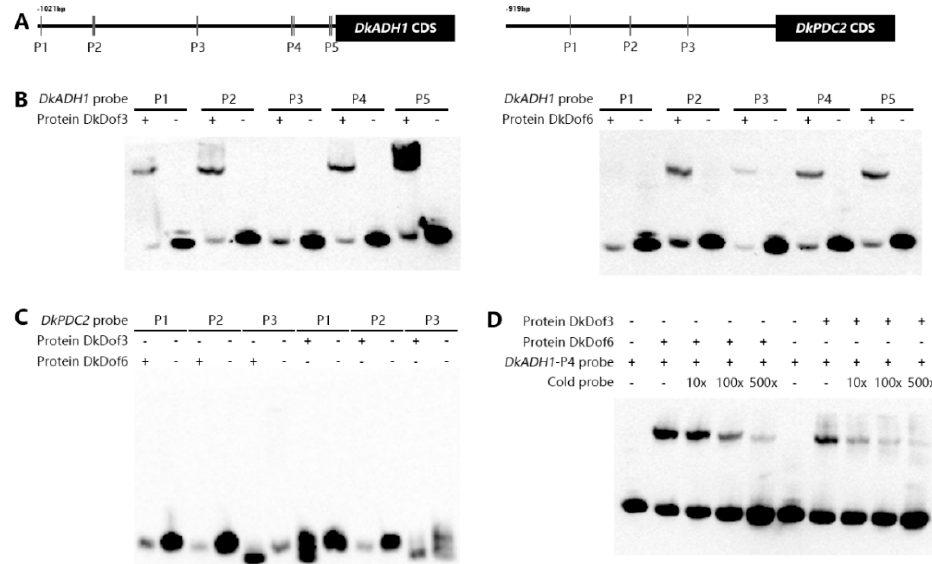
Figure 5. The binding abilities of DkDof3 and DkDof6 to the promoters of DkADH1 and DkPDC2 . ( A ) The location of binding motifs (T/AAAAG) for Dof family TFs in the promoters of DkADH1 and DkPDC2 . ( B , C ) The binding abilities of different probes with the core motif. ( D ) Verification of the binding effects by competition of unlabeled DkADH1 -P4 probe (cold probe).